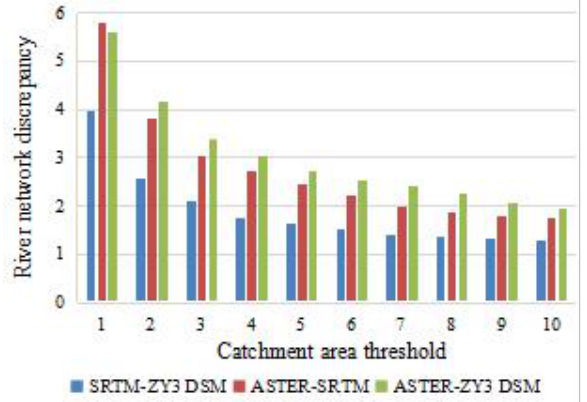
Figure 8. River networks discrepancy The river network discrepancy between ASTER and ZY3 DSM is the biggest among the three except when the catchment area threshold is 1km 2 . The larger river network discrepancy, the lower similarity of the two rivers,and the smaller river network discrepancy, the higher similarity of the two rivers. So it can conclusion that the similarity between ZY3 DSM and SRTM is the highest one, but the similarity between ZY3 DSM and ASTER is the lowest one from all the results